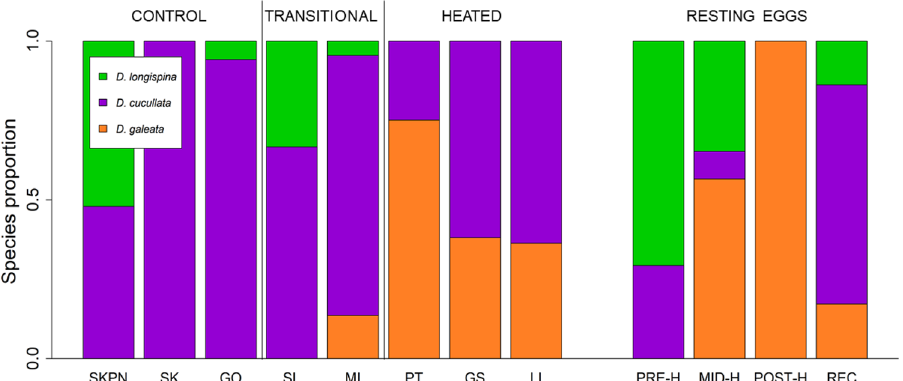
Figure 4. Species composition in the investigated lakes of contemporary samples and resting eggs of Daphnia , based on DAPC analyses. Contemporary samples are grouped as follows: three control lakes (SKPN, SK, GO), two transitional heated lakes (SL, MI), and three heated lakes (PT, GS, LI). Resting eggs are grouped as follows: PRE-H—produced before the onset of heating, MID-H—produced after the launch of the first plant but before the launch of the second power plant, POST-H—produced in the ca. 15 years following the launch of the second power plant, REC—produced recently, i.e. within 15 years of core collection.